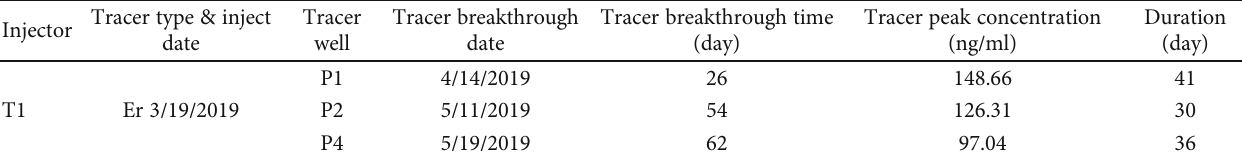
Figure 17: The dividing coe ffi cient diagram of the T1 well group. Table 2: Tracer test results of the T1 well